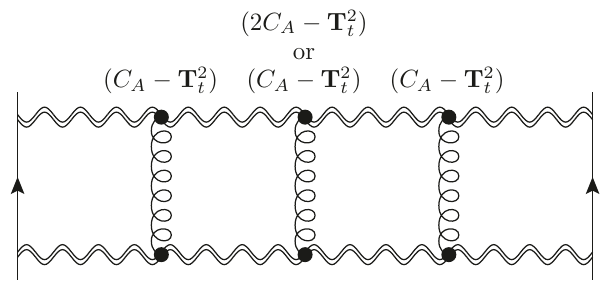
Figure 4 . Graphical representation of the BFKL ladder at four loops. The fact that (cid:10) (1) ( p; k ) (cid:24) ( C A (cid:0) T 2 ) in conjunction with the target-projectile symmetry imply that the (cid:12)rst rungs on either t side can only give rise to contributions proportional to ( C A (cid:0) T 2 structures can appear for the (cid:12)rst time at four